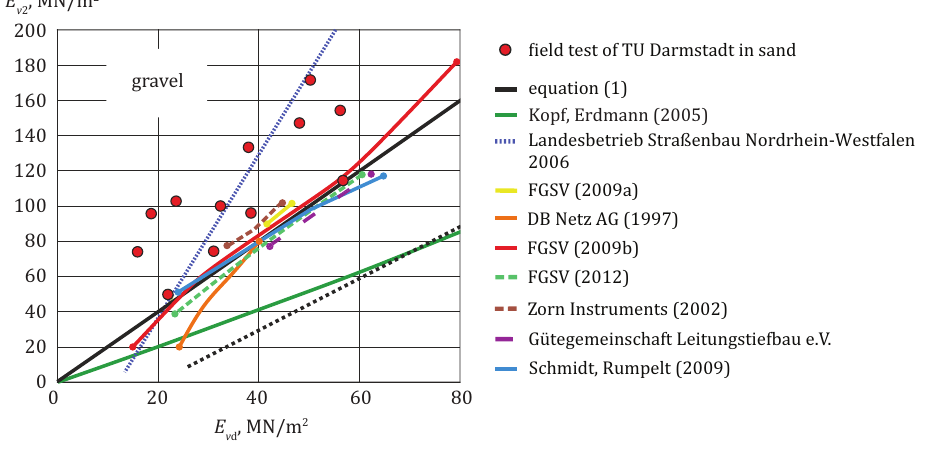
Figure 6. Correlations for